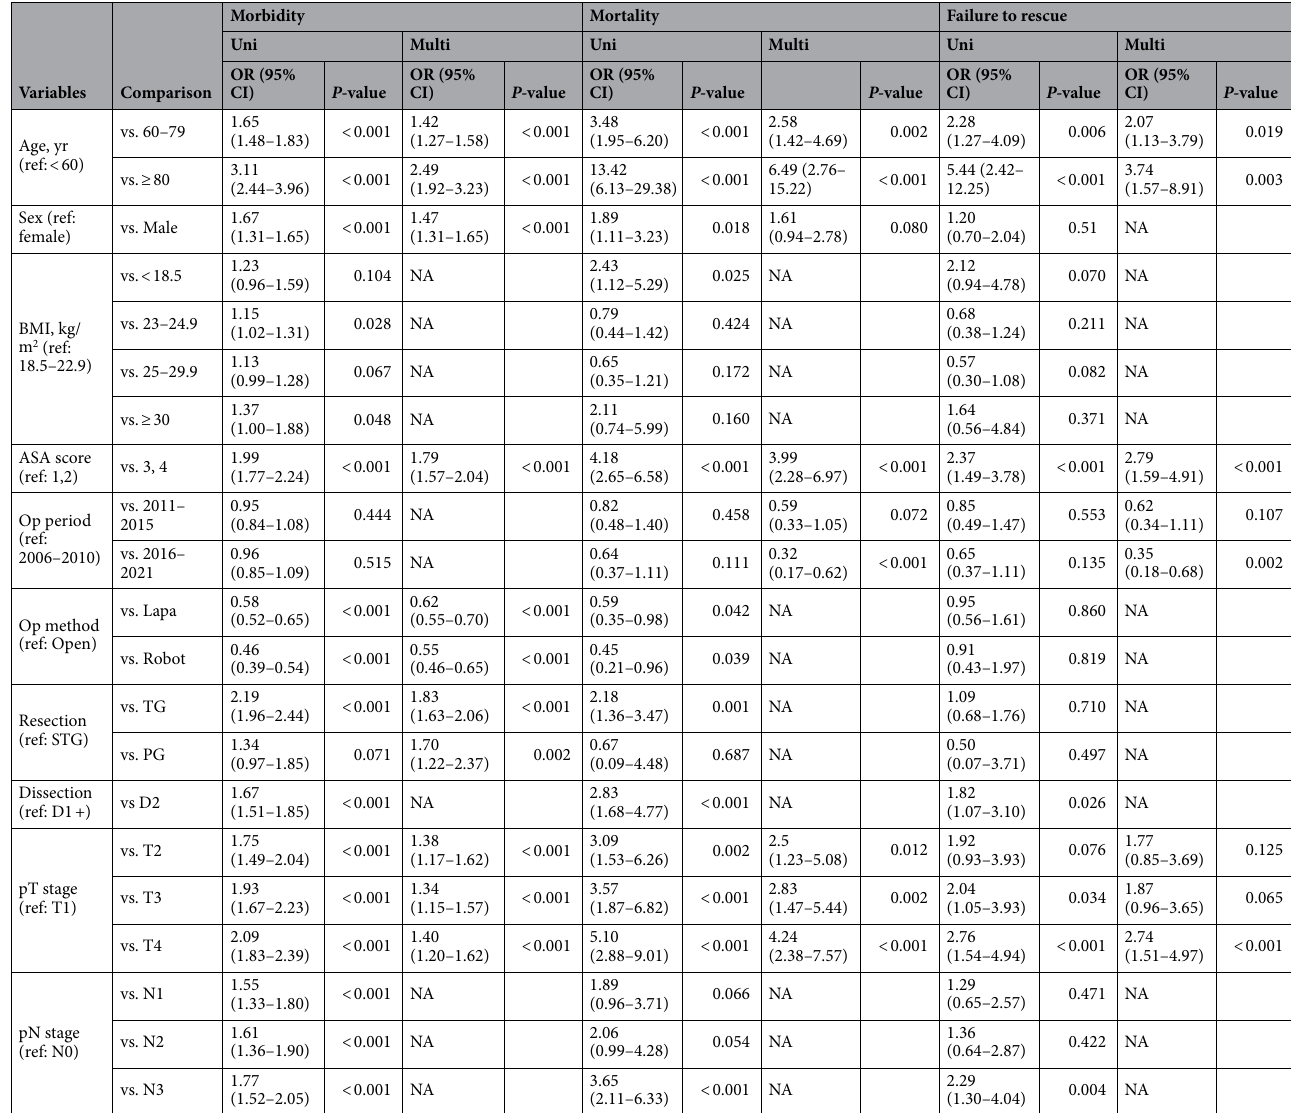
Table 2. Logistic regression models for risk factor analysis of morbidity, mortality, and failure to rescue after gastrectomy. Uni univariable; Multi multivariable; OR adjusted odds ratio; CI confidence interval; ref reference; BMI body mass index; ASA American Society of Anesthesiology; Op operation; Lapa laparoscopic; Robot robotic; STG subtotal gastrectomy; TG total gastrectomy; PG proximal gastrectomy; NA not